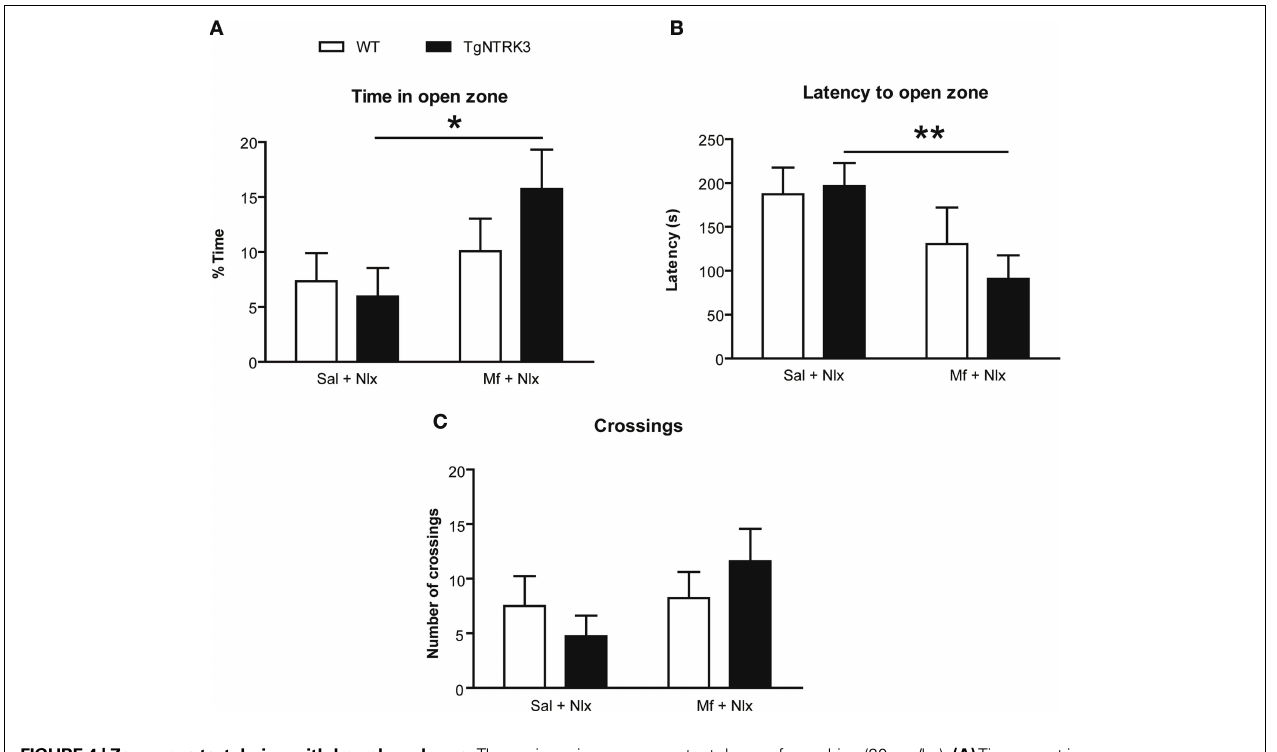
FIGURE 4 | Zero-maze test during withdrawal syndrome. The anxiogenic effects of morphine withdrawal were studied using the zero-maze test immediately after evaluation of withdrawal symptoms in animals receiving